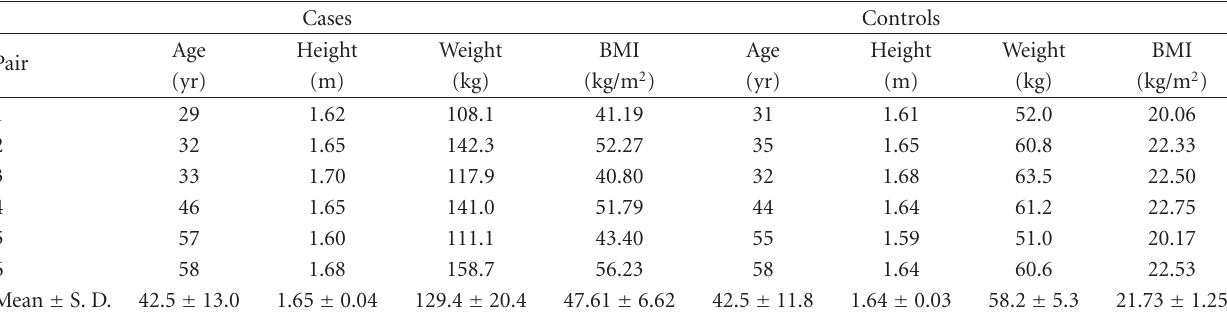
Table 2: Participant characteristics.